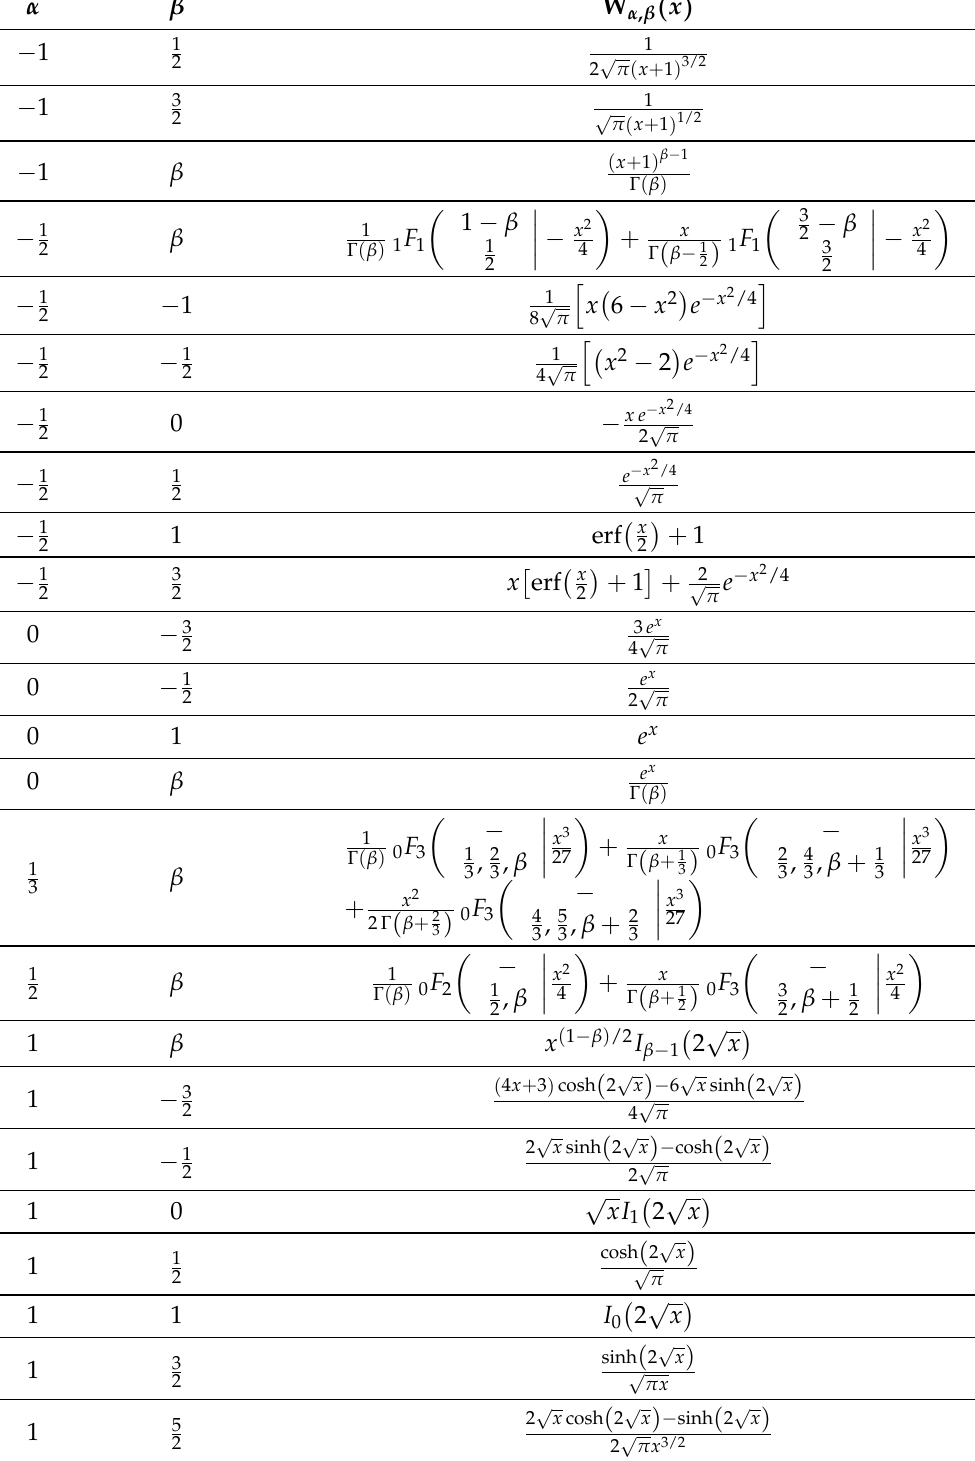
Table A13. The Wright functions W α , β derived for some values of parameters α and β by using